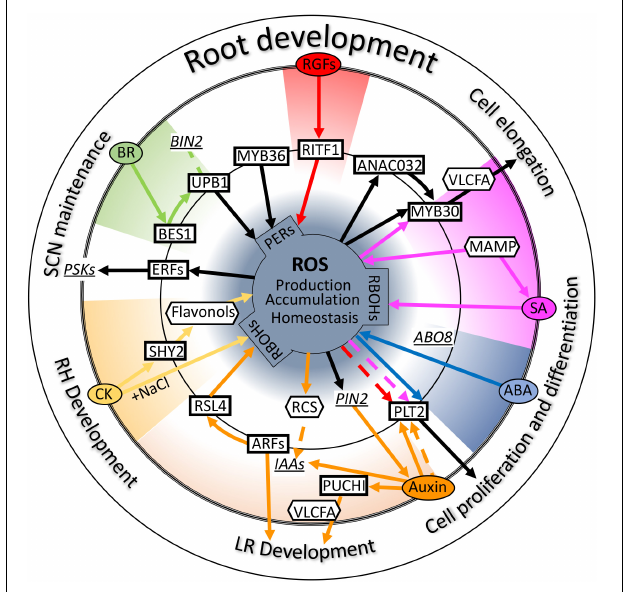
FIGURE 2 | Crosstalk between reactive oxygen species (ROS) and plant hormones. Schematic diagram of the crosstalk of several hormones and ROS signals centered on some key transcription factors involved in root development. Ovals, rectangles, and hexagons indicate signal molecules such as plant hormones, transcription factors, and secondary messenger molecules, respectively. Underlined italicized letter indicate genes involved in these signals as important intermediators. Solid lines refer to “transcriptional regulation,” and dotted lines indicate “regulation at the protein level.” Black lines indicate direct regulation by ROS or regulation of ROS homeostasis. Colored lines indicate each signal transduction. Please see the main text for further details. Auxin (orange); ABA, abscisic acid (blue); BR, brassinosteroid (green); CK, cytokinin (yellow); SA, salicylic acid (purple); RGFs, root meristem growth factors (red); PERs, peroxidases; PSKs, phytosulfokines; RCS, reactive carbonyl species; LR, lateral root; RH, root hair; SCN, stem cell